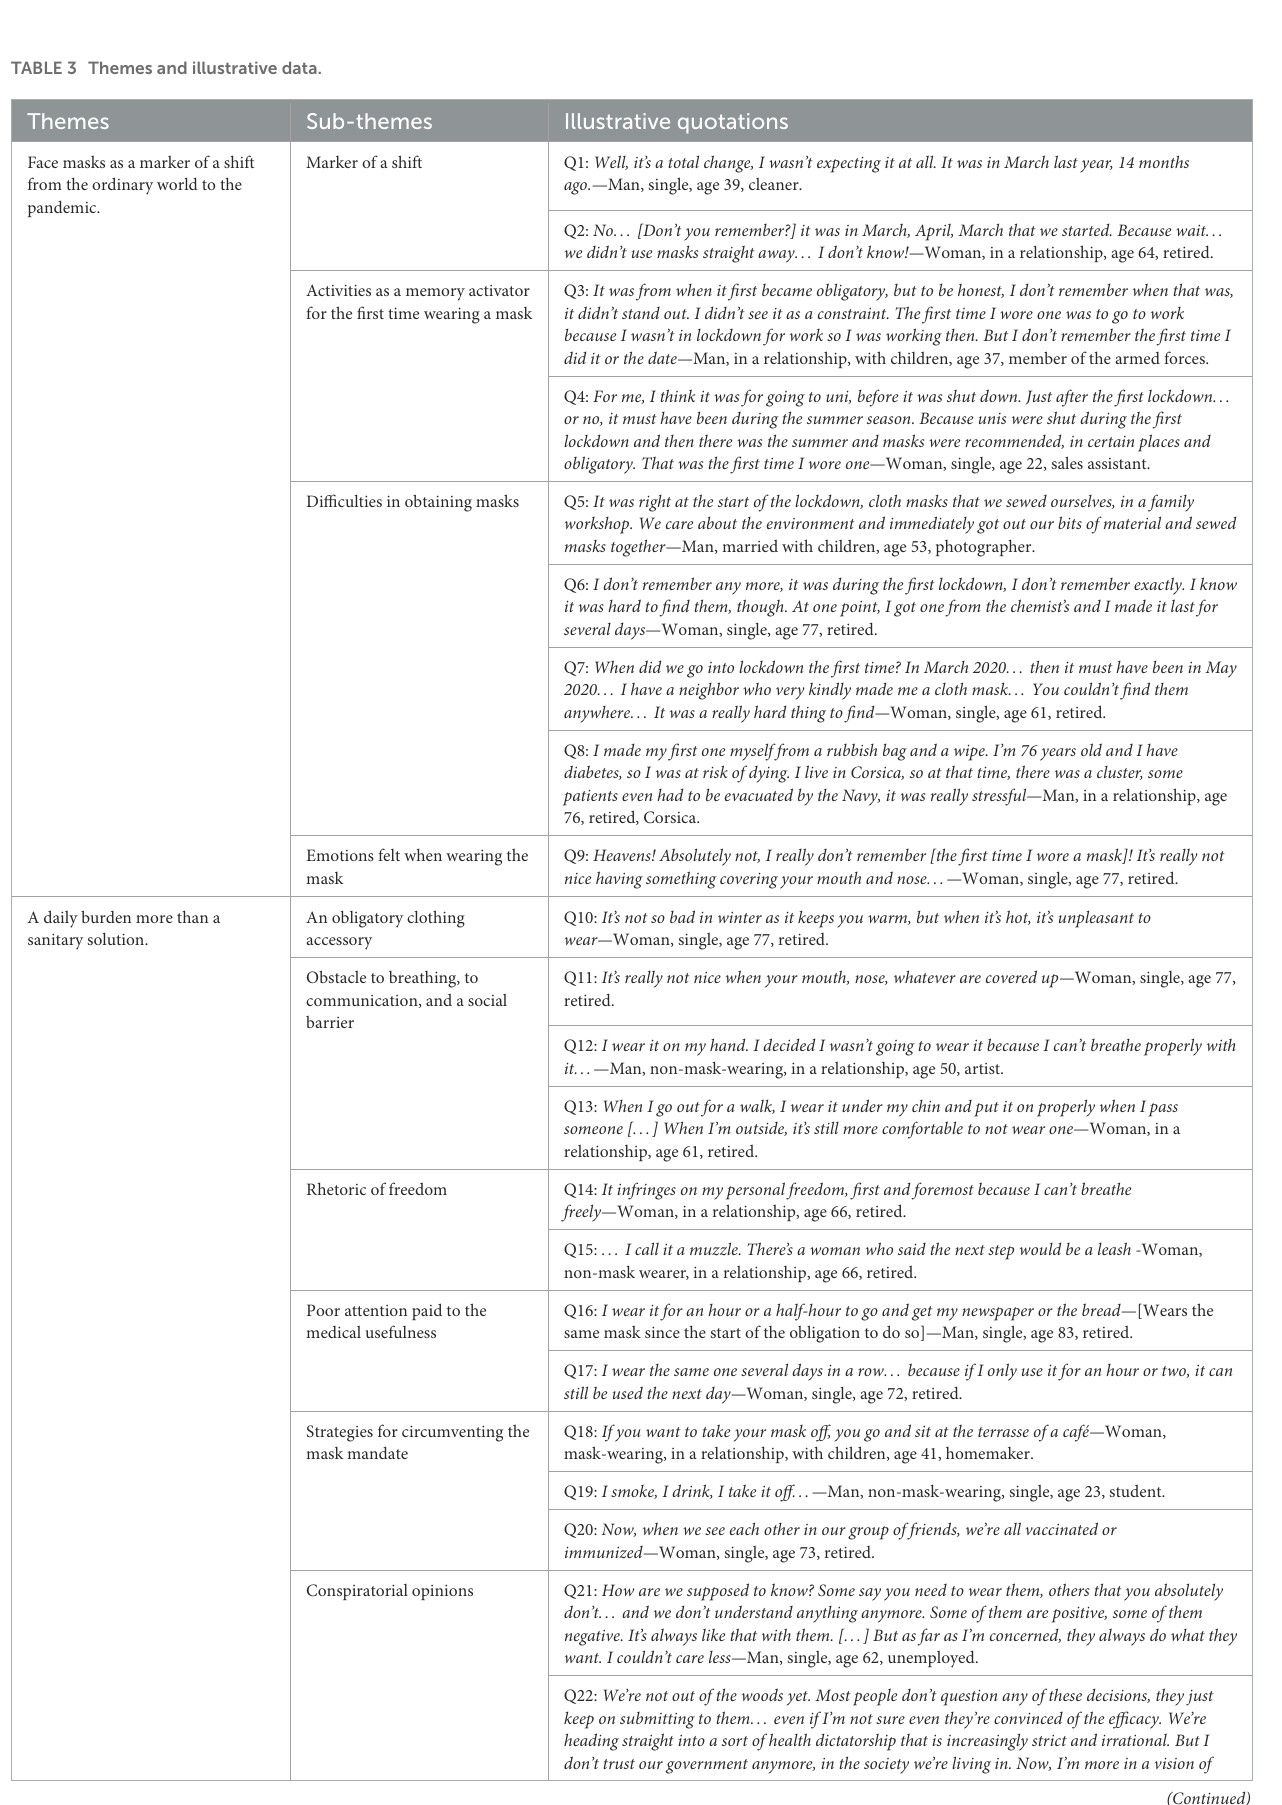
TABLE 3 Themes and illustrative data.